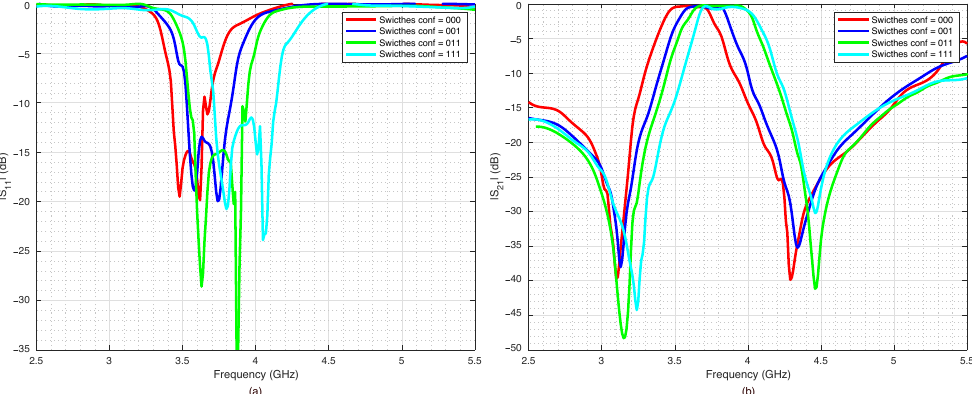
Figure 18. Measured scattering parameters of the pseudohairpin filter prototype for all the considered combinations, ( a ) return loss S 11 , ( b ) insertion loss S 21